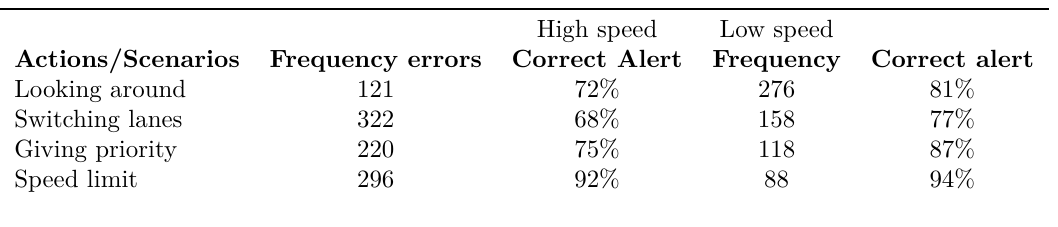
Table 2. Frequency of detected actions generated alerts.